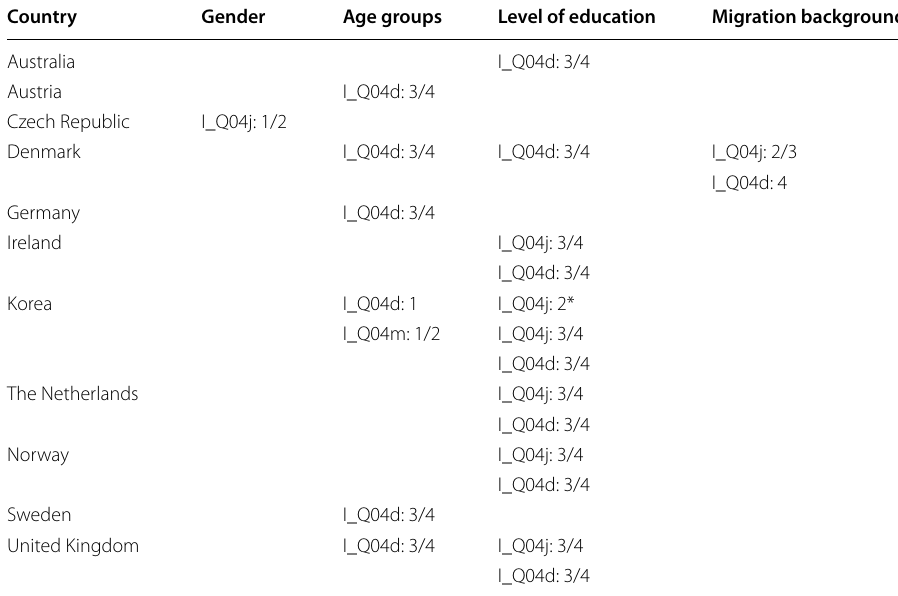
Table 7 Overview of freed parameters for testing partial measurement invariance (item: thresholds that have been